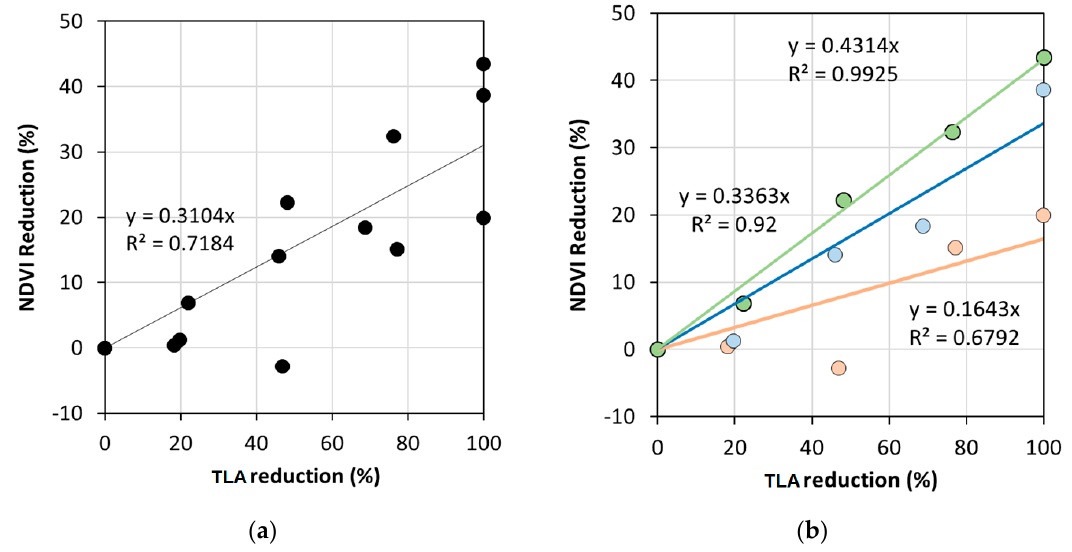
Figure 6. Relationship between NDVI (%) and TLA reduction (%) ( a ) in all pixels ( b ) per pixel.